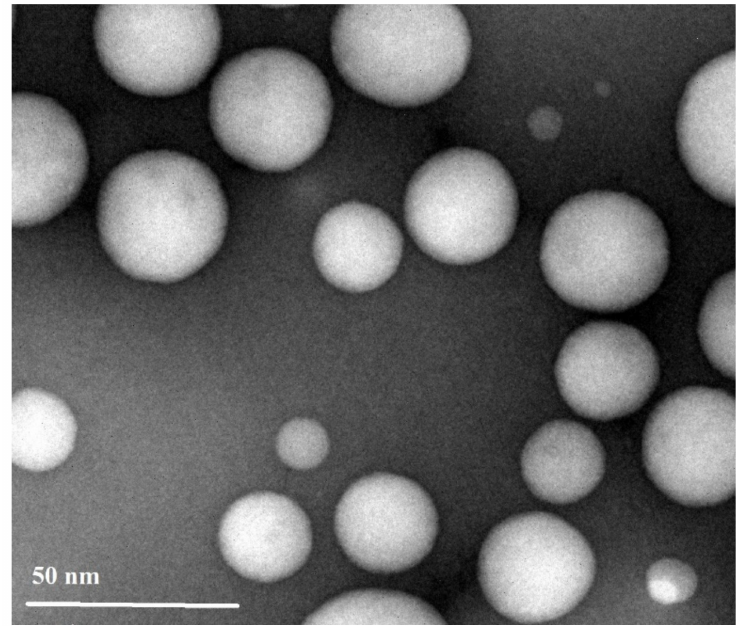
Figure 6. TEM of olanzapine polymeric